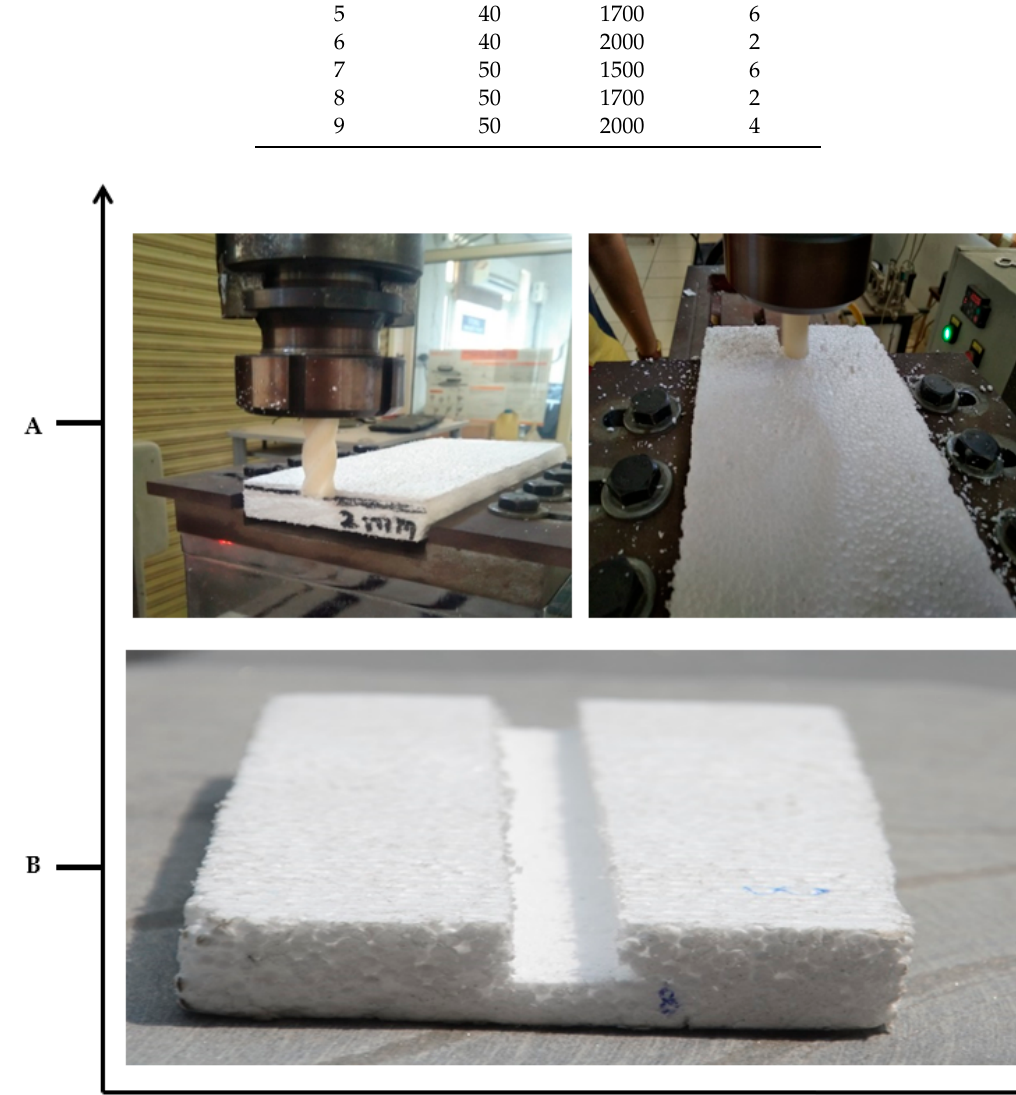
Figure 2. Pictorial views of the end-milling of the expandable polystyrene (EPS) using: A, 3D printed tool and B, as-machined EPS.